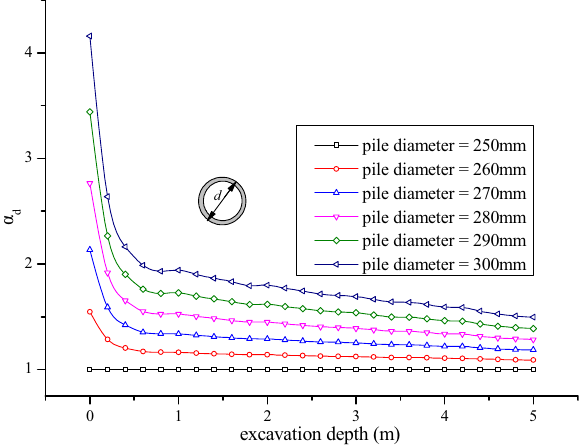
Figure 8. Influence of pile diameter on the critical load at different excavation